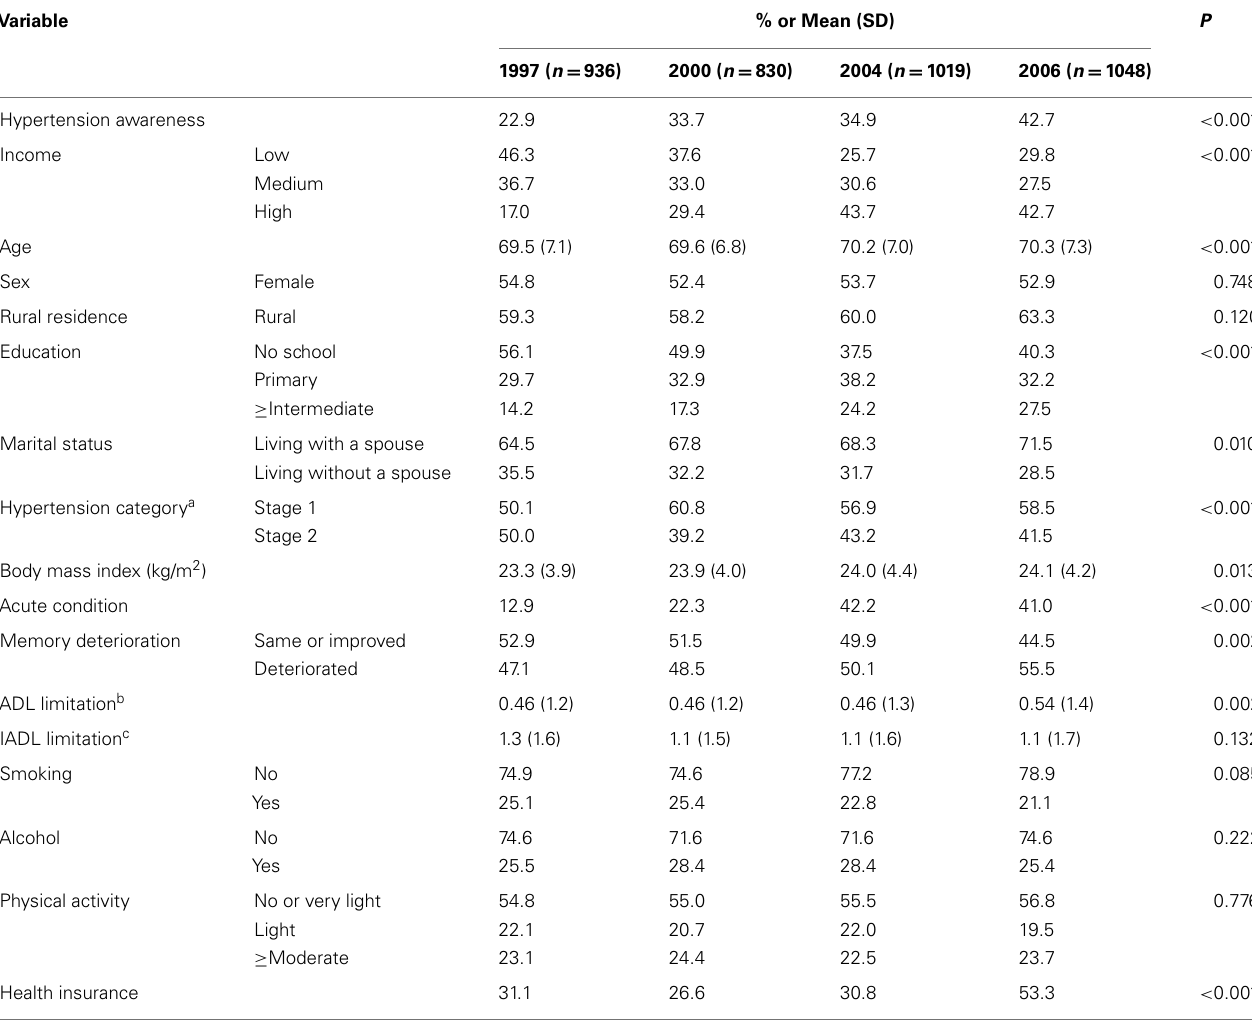
Table 1 | Characteristics of study participants in the China health and nutrition survey ( n = 2404) from 1997 to 2006 .